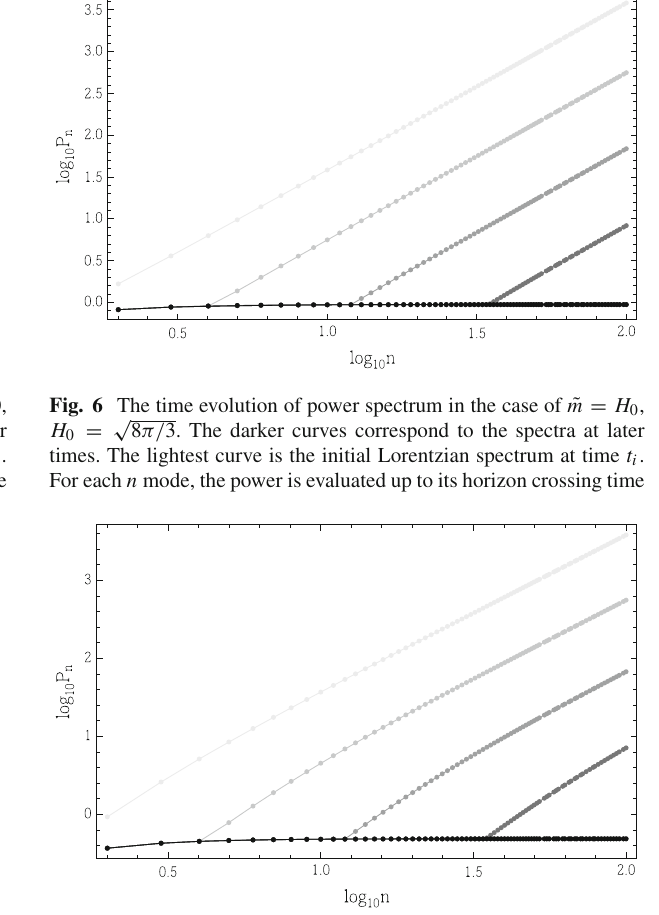
Fig. 5 Thetimeevolutionofpowerspectruminthecaseof ˜ m = 0 . 5 H 0 , √ H 0 = 8 π/ 3.Thedarkercurvescorrespondtothespectraatlatertimes. The lightest curve is the initial Lorentzian spectrum at time t i . For each n mode, the power is evaluated up to its horizon crossing time